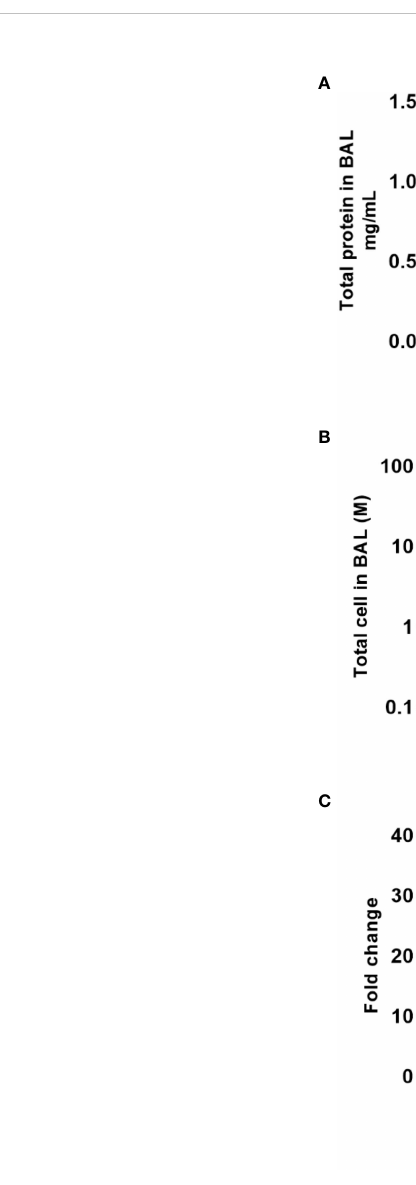
FIGURE 2 Increased lung damage and BAL in fl ammatory response to LPS exposure in CD200 KO. WT and CD200 KO rats were exposed to LPS intratracheally. Lung damage was assessed by (A) total protein in BAL, whereas in fl ammation was measured by (B) BAL total cell accumulation. (C) Total BAL cells were expressed as a fold change from baseline (time = 0h). Data are from individual rats, with n = 6-8 per group of two independent experiments. Statistical signi fi cance was determined using two-way ANOVA followed by Bonferroni ’ s multiple comparisons; * P < 0.05 vs WT; **P < 0.05 vs WT; ***P < 0.05 vs WT; # P < 0.05 vs